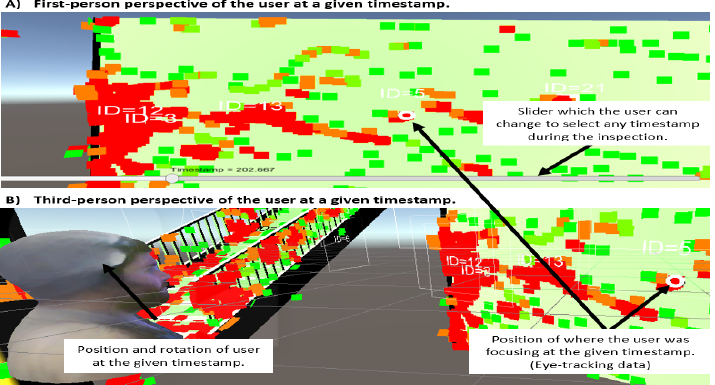
Figure 11. This figure showcases the developed 4D Playback Analysis Tool. Image ( A ) presents a playback of the inspector from a first-person perspective and Image ( B ) from a third-person perspective. The user can adjust the timestamp of the system, and it will display the exact position of where the user was in the real world at that time and where the user was looking. A heatmap is dynamically produced to keep track of where the user has and has not